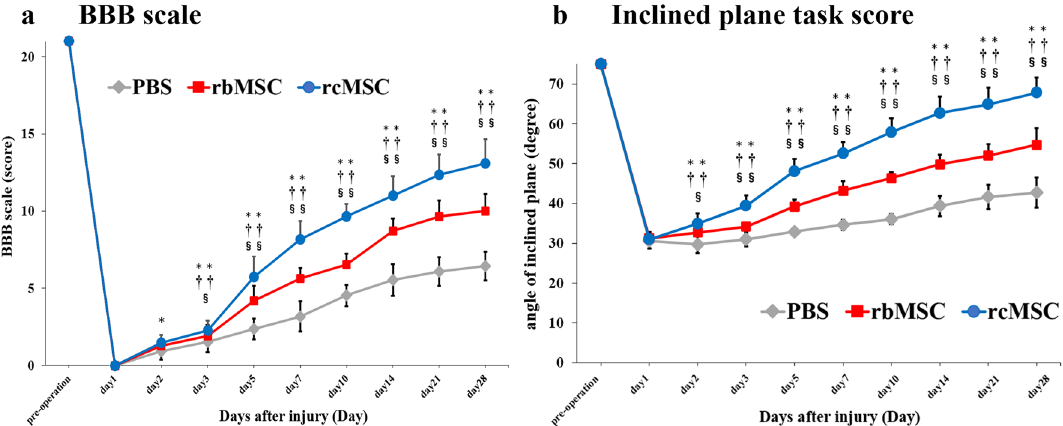
Figure 2. Effect of cell transplantation on motor function recovery. Results of the BBB scale ( a ) and inclined plane task score ( b ). Data are presented as the mean ± SD. * PBS group vs rcMSC group; † PBS group versus rbMSC group; § rcMSC group vs rbMSC group. Rats in the rcMSC group showed more significant improvements in BBB scale and inclined plane task score than rats in other groups (* P < 0.05, ** P < 0.01, †† P < 0.01, § P < 0.05, and §§ P < 0.01, respectively, n =